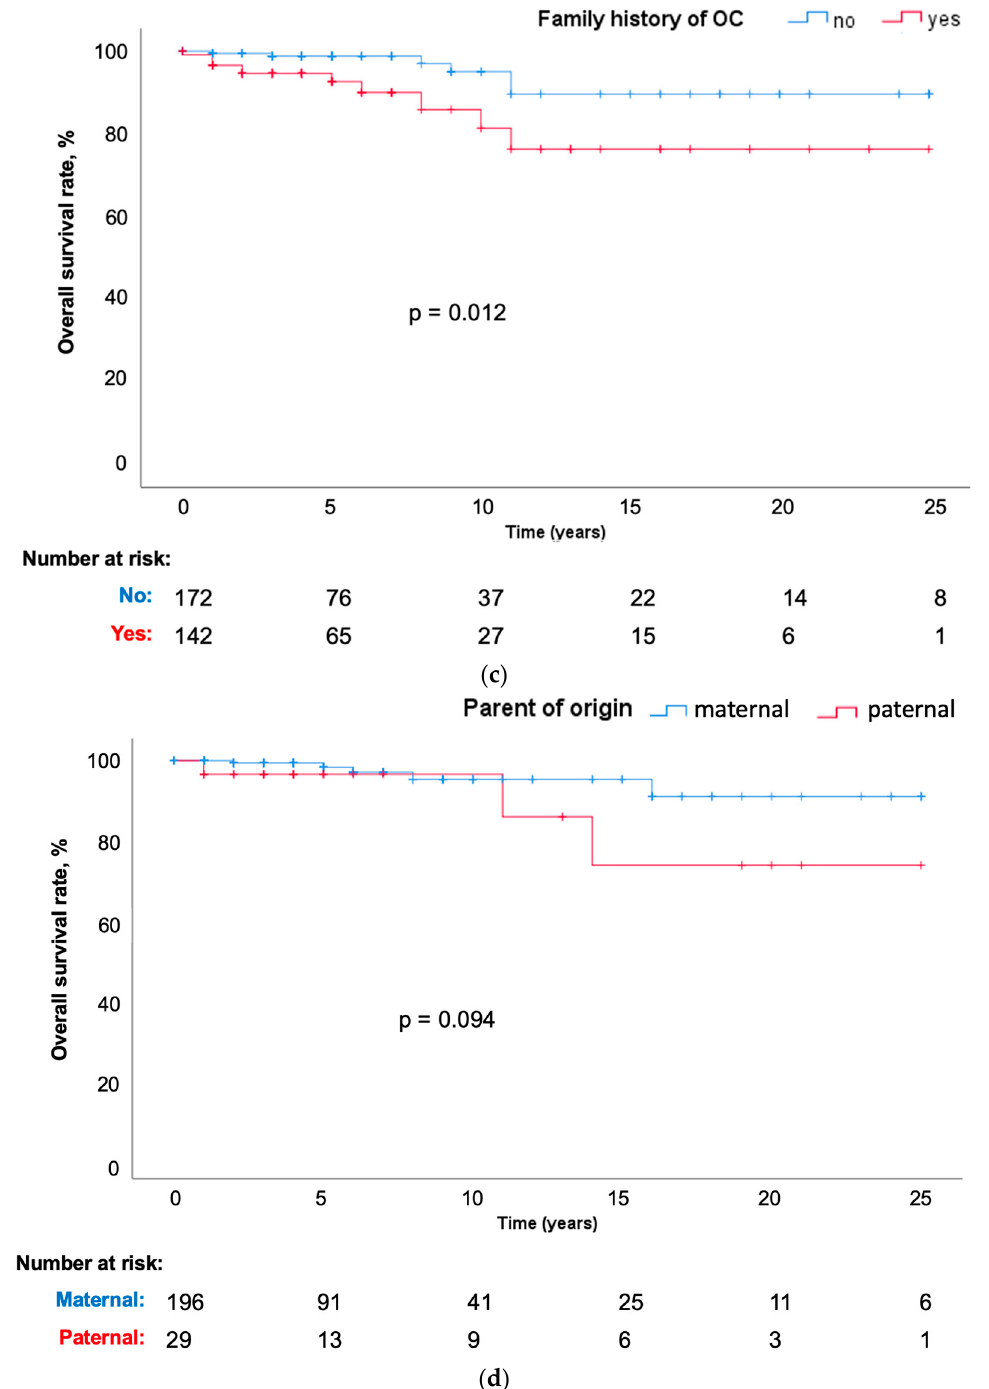
Figure 3. ( a ) OS by mutation type. ( b ) OS and family history of BC. ( c ) OS and family history of ovarian cancer. ( d ) OS and parent of origin.